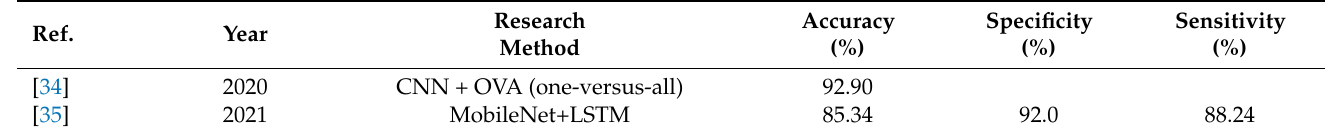
Table 3. Comparison of accuracy, specificity, and sensitivity with other research work using the HAM-10000 dataset.